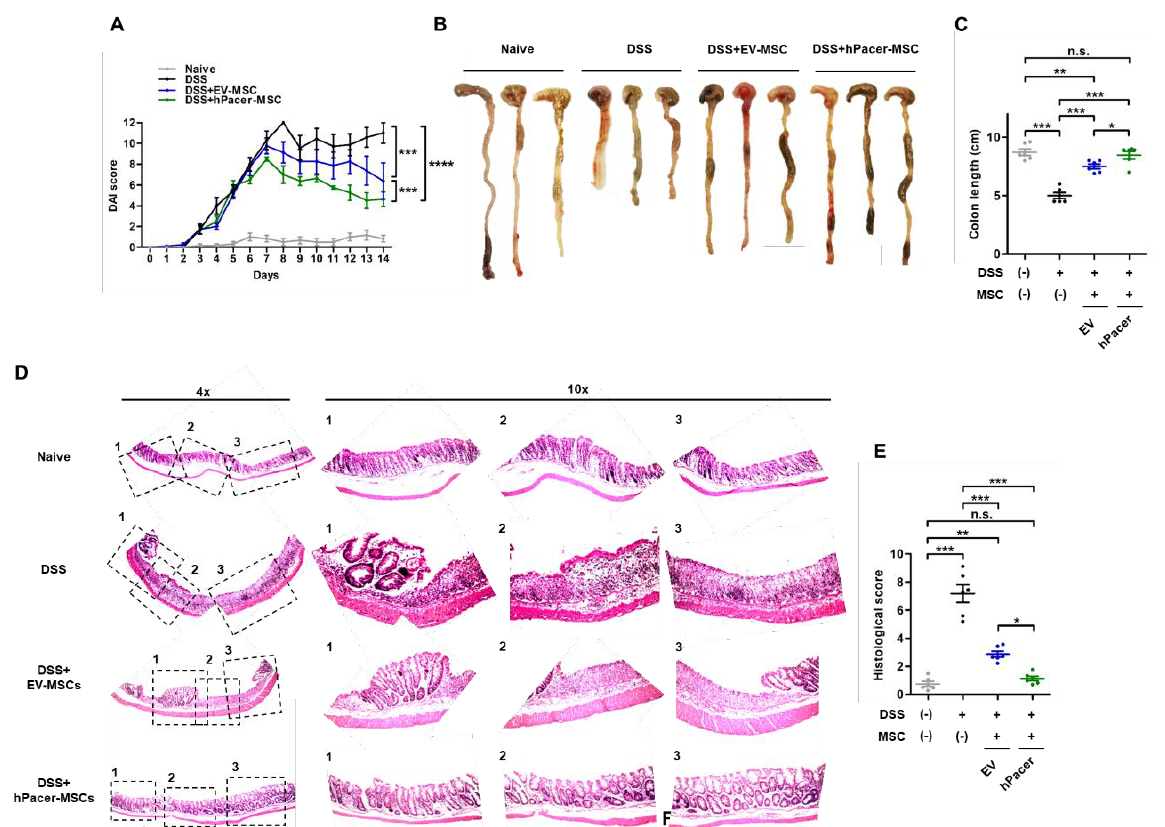
Figure 4. Upregulation of Pacer in MSC improves their therapeutic effects on DSS-induced inflammatory colon injury. ( A ) The disease activity index (DAI) scores of naïve ( n = 6), DSS ( n = 7), DSS+EV-MSC ( n = 8) and DSS+hPacer-MSC ( n = 8) were determined daily. The DAI was calculated from cumulative scores for body weight loss, stool consistency and presence of bleeding. ( B , C ) The colon length of each experimental group was measured, and the results were graphically dis- played. ( D , E ) Histology of the colon was performed on day 14. ( D , E ) Representative images of the appearance of colon tissue are shown in ( D ) for naïve, DSS, DSS+EV-MSC and DSS+hPacer-MSC treated groups. ( E ) Images of each animal were analyzed, and histopathological scores were deter- mined. ( A , C , E ) Mean ± SEM are shown. In ( A ), two-way ANOVA and in ( C , E ), one-way ANOVA with Tukey post hoc test were performed for statistical analysis. Only significant p values are shown. p values: *, p ≤ 0.05; **, p ≤ 0.01; ***, p ≤ 0.001; ****, p ≤ 0.0001. 4. Discussion Several recent in vitro and preclinical studies have demonstrated the therapeutic po- tential of MSC while used as a treatment for diverse pathological conditions, e.g., diabetes, neurodegenerative diseases, inflammatory or autoimmune disorders, among others [8,46,47]. Initially, the therapeutic capacity of MSC had been attributed to their ability to differentiate into various cell lineages, hence replacing damaged cells [48]. Nonetheless,